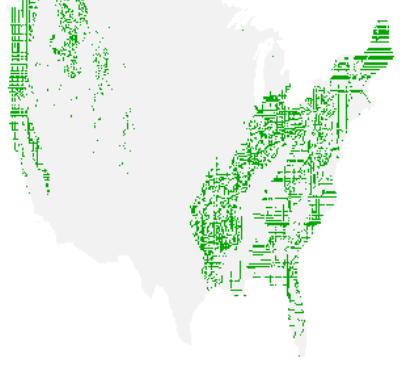
Figure 8. Precipitation pattern change of deformation in clockwise direction